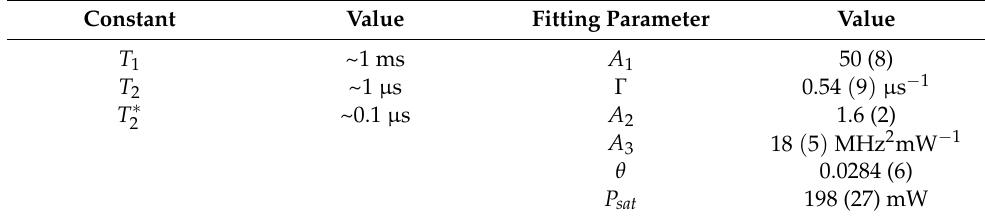
Table 2. The constants and fitting parameters in Equations (1) and (2). Constant Value Fitting Parameter